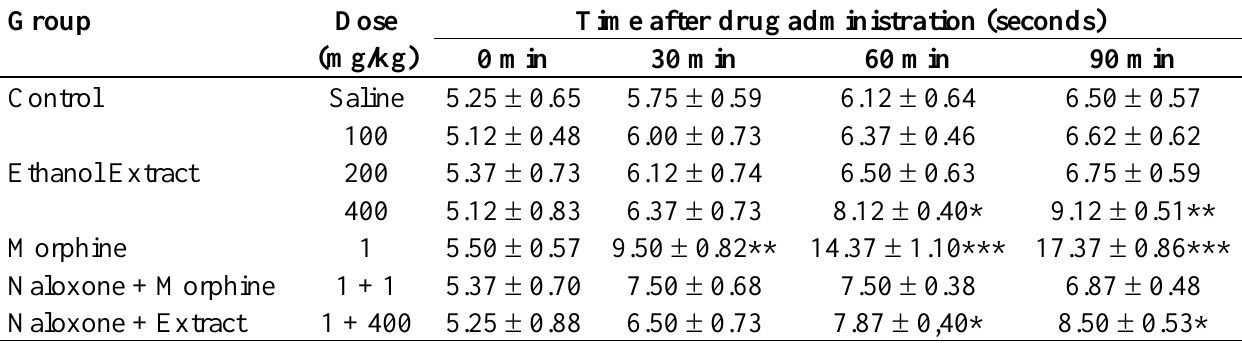
Table 1. Effects of the ethanol extract from M. platyclada leaves on the reaction time(s) of mice exposed to the hot-plate